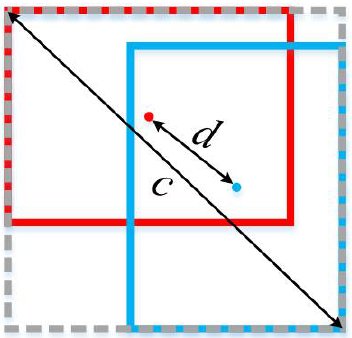
Figure 6. Details of DIoU loss. The red box, blue box, and gray box are the predicted box, ground truth box, and C detection box, respectively.